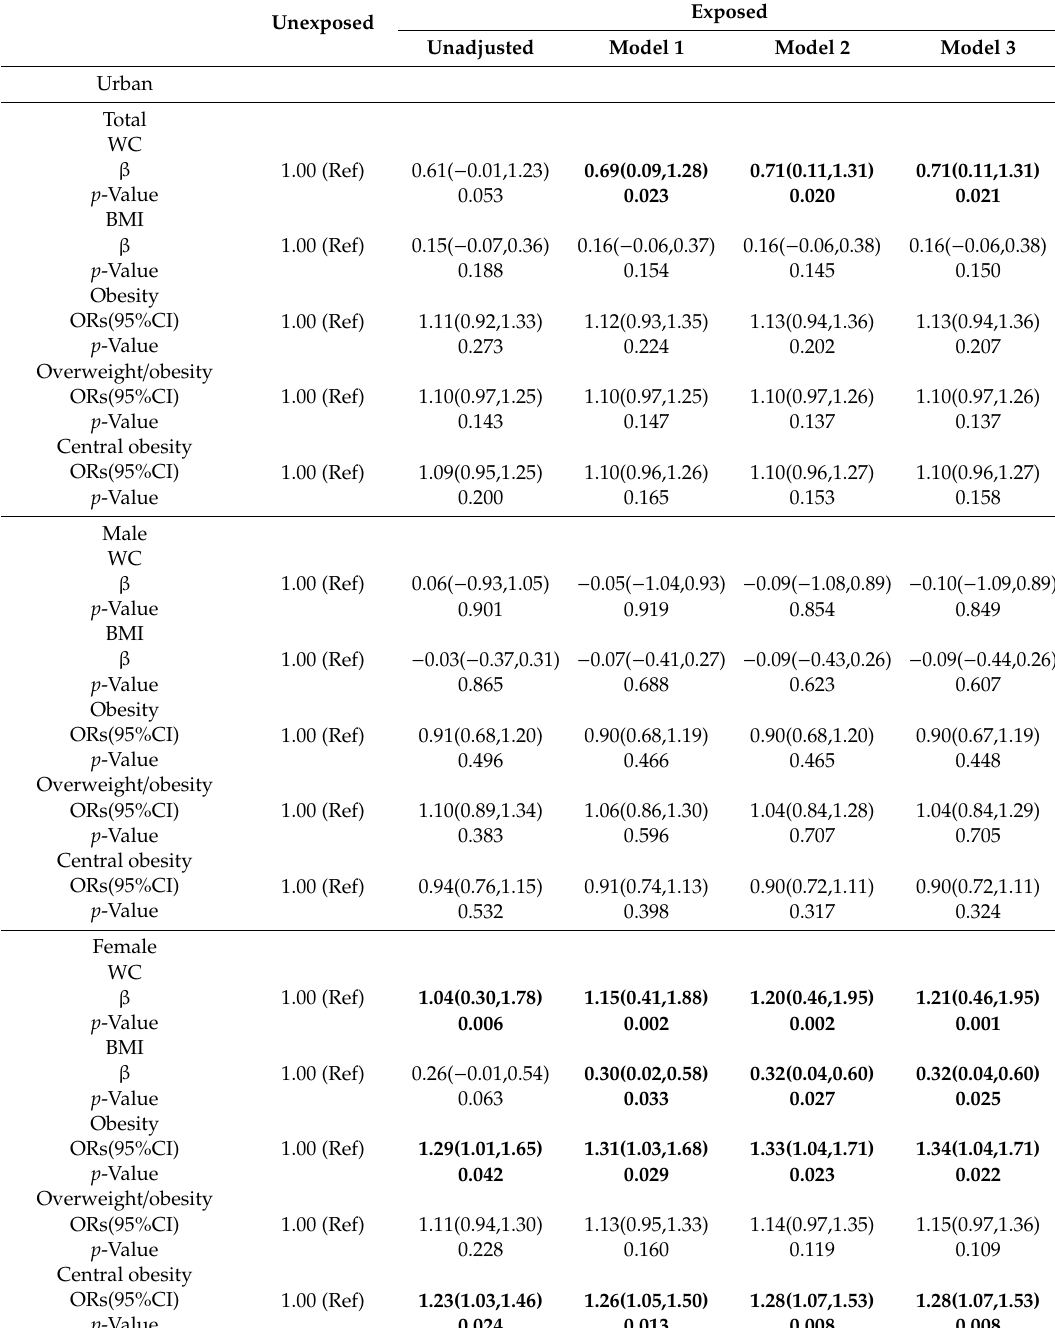
Table 3. Associations between fetal famine exposure and obesity risk in di ff erent areas. Unexposed